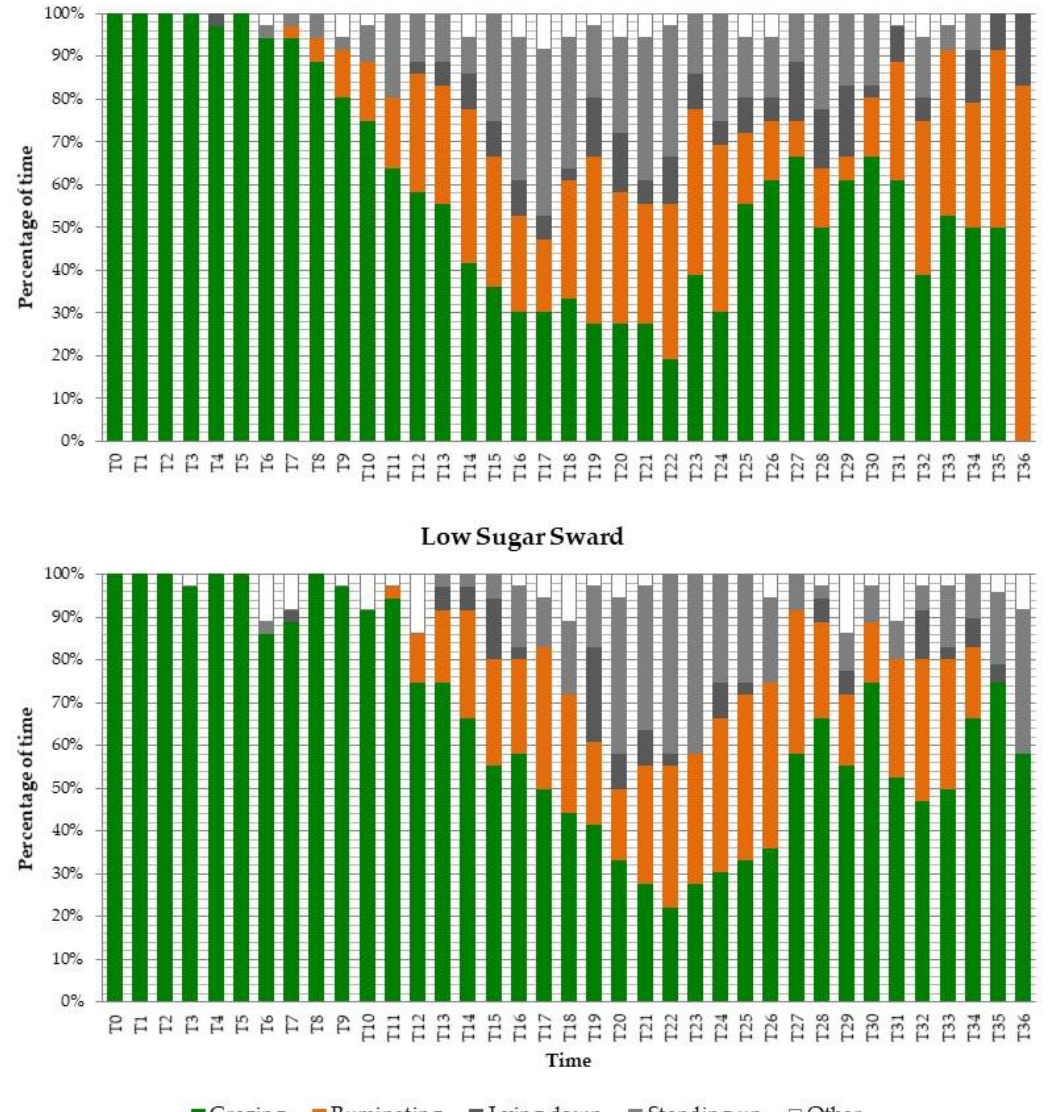
Figure 1. Ethogram of dairy cows grazing on a perennial ryegrass pasture with high (32.2% DM) and low (22.4% DM) contents of water-soluble carbohydrates. T0 corresponds to 9:30 and T36 corresponds to 15:30 (observations performed every 10 minutes by one observer). Bars are averages over six days. Table 3. Milk production and composition from dairy cows grazing on a perennial ryegrass pasture with high (32.2% DM 1 , HS) and low (22.4% DM, LS) contents of water-soluble carbohydrates 1